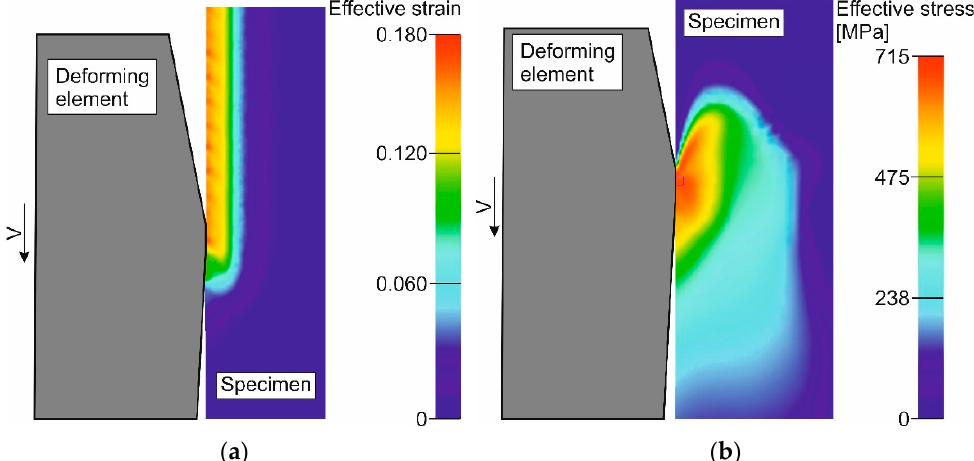
Figure 9. The distributions of accumulated strain ε 0 and stress intensity σ 0 in the machined workpiece: ( a ) distributions of accumulated strain, ( b ) stress intensity. The accumulated strain ε 0 variation and the axial component of the stress tensor σ z , depending on the tracking point coordinate-L and, respectively, along the machined surface length of the workpiece, are shown in Figure 10.